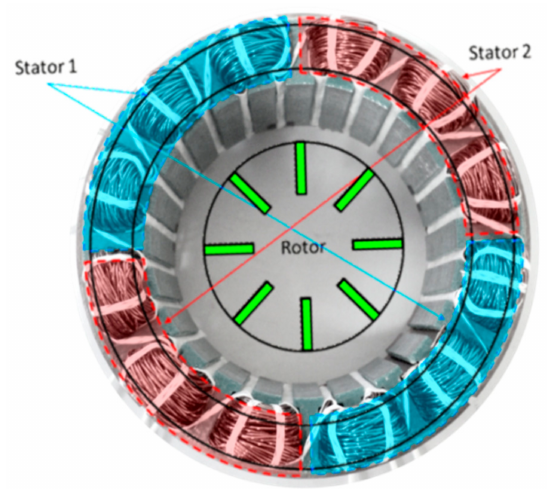
Figure 2. View of one structure.